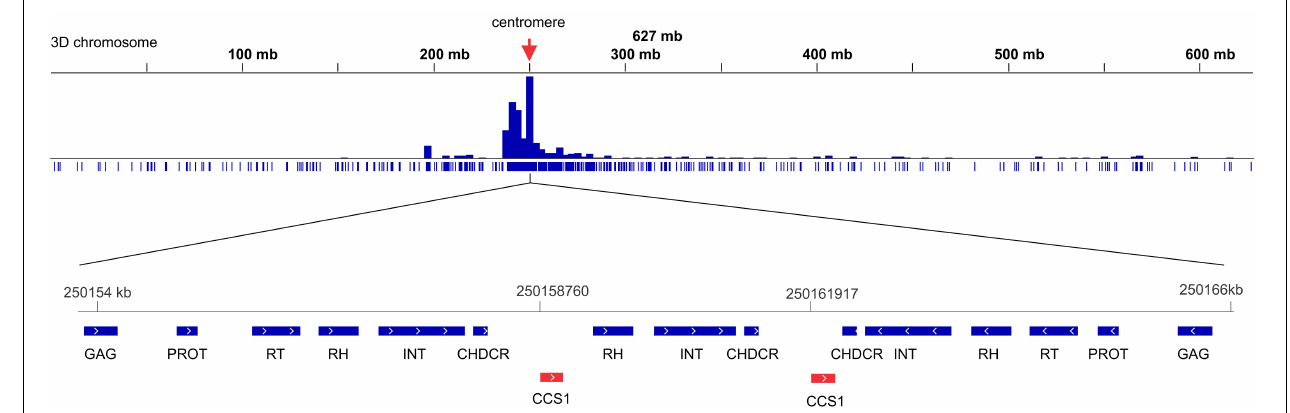
FIGURE 7 | Density of CRM lineage of Ty3/gypsy retrotransposon along the chromosome 3D of Ae. tauschii . A small part from the centromeric region which is highly enriched in CRM elements has been show in detail. BLASTn mapped the Triticeae specific CCS1 centromeric repeat (red elements) between the CRM elements. CHDCR, chromodomain of centromeric retrotransposons; INT, integrase; PROT, protease; RH, ribonuclease H; RT, reverse transcriptase.